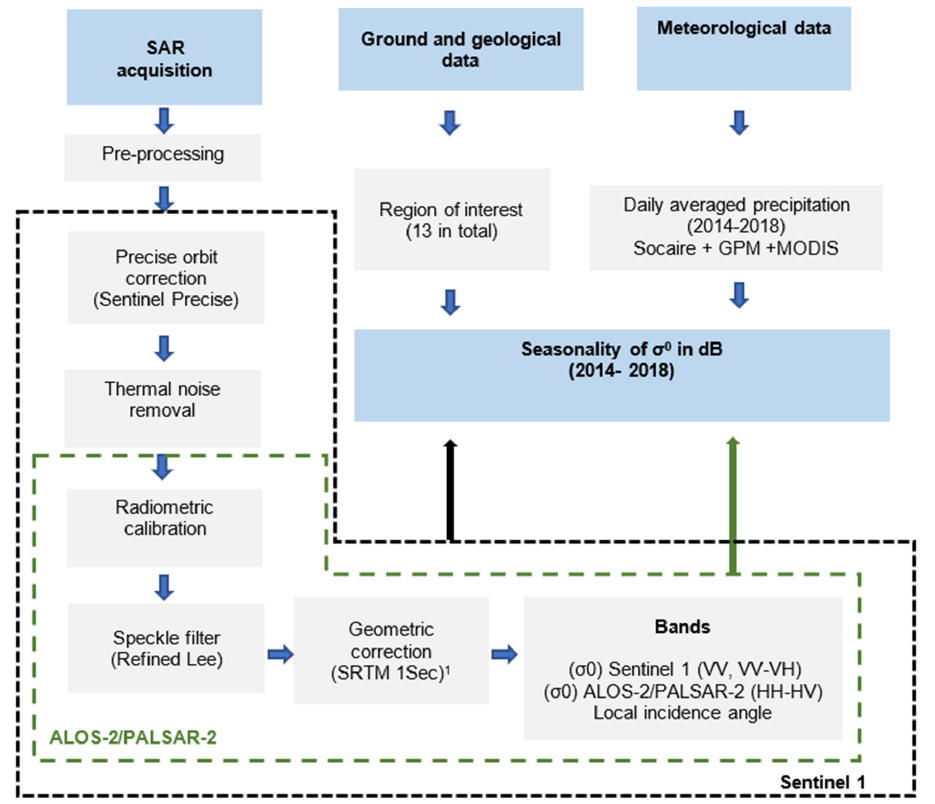
Figure 2. Methodological flowchart for the four-year data sets. 1 Digital Model